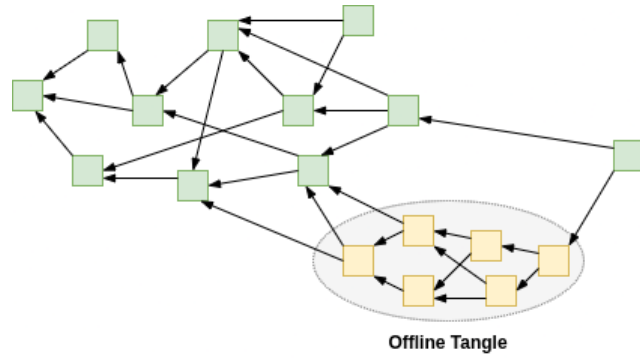
Figure 6. Offline Tangle synchronizing